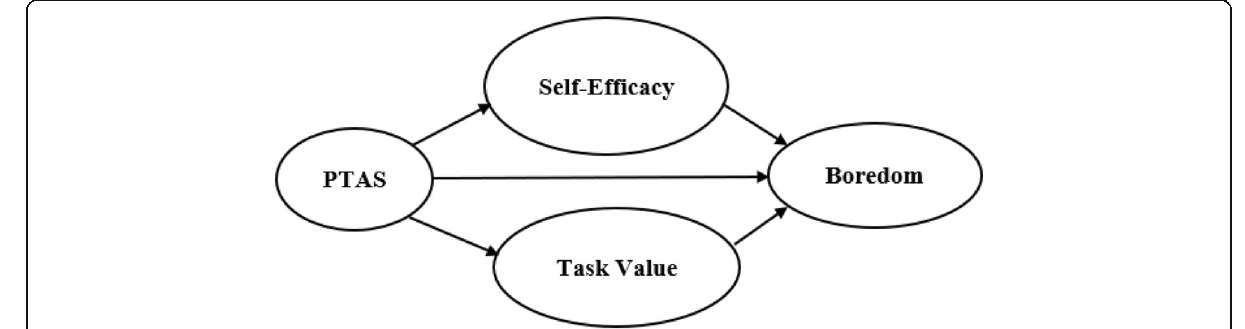
Fig. 2 The partial mediation model showing structural relationship between the study